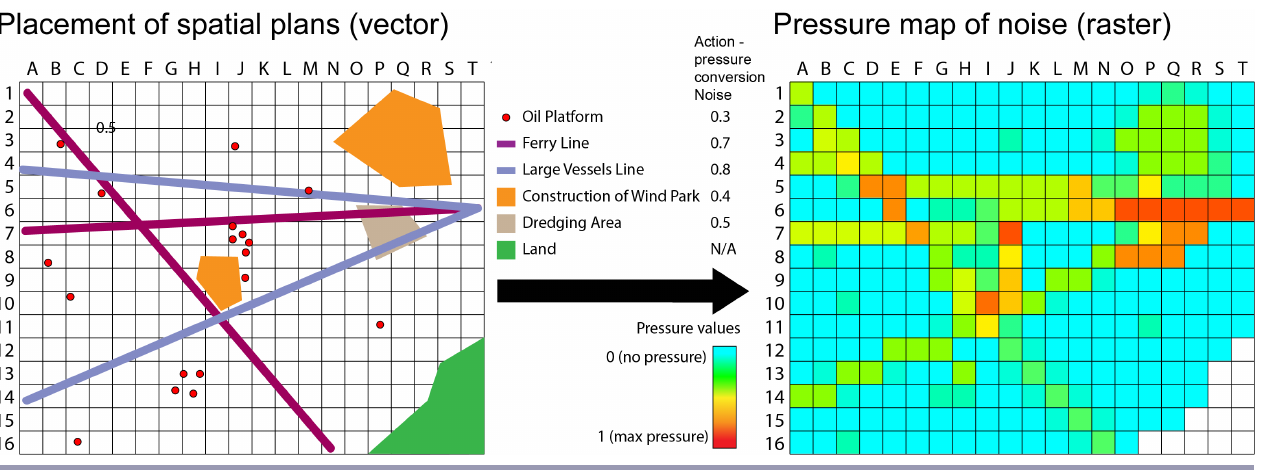
Fig. 3. Schematic overview showing how spatial plans (actions), in vector format, are converted to pressure grids, in raster format. This example shows how oil platforms, ferry and shipping lines, wind park construction, and dredging contribute to the noise pressure grid via conversion factors unique to each type of